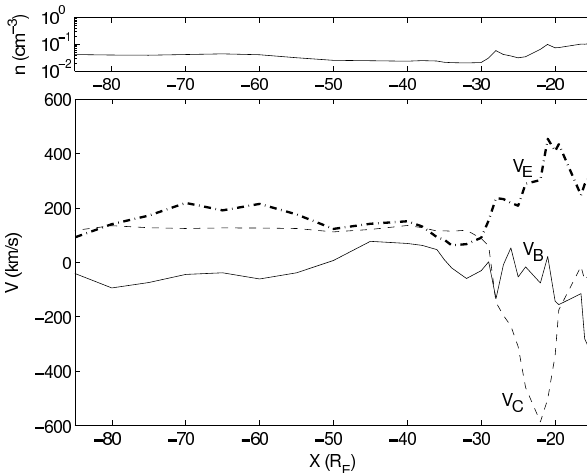
Fig. 18. Model (top) density and (bottom) velocity moments cal- culated in the magnetotail CS region ( Z = 0 . 0001 R E ) in the noon-midnight meridian. The velocities are expressed in terms of the directions of the magnetic field ( V B ), electric field ( V E ) and convection velocity ( V C ). At these locations in the CS region V C ≈ V x ,V B ≈ V z ,V E ≈ V y